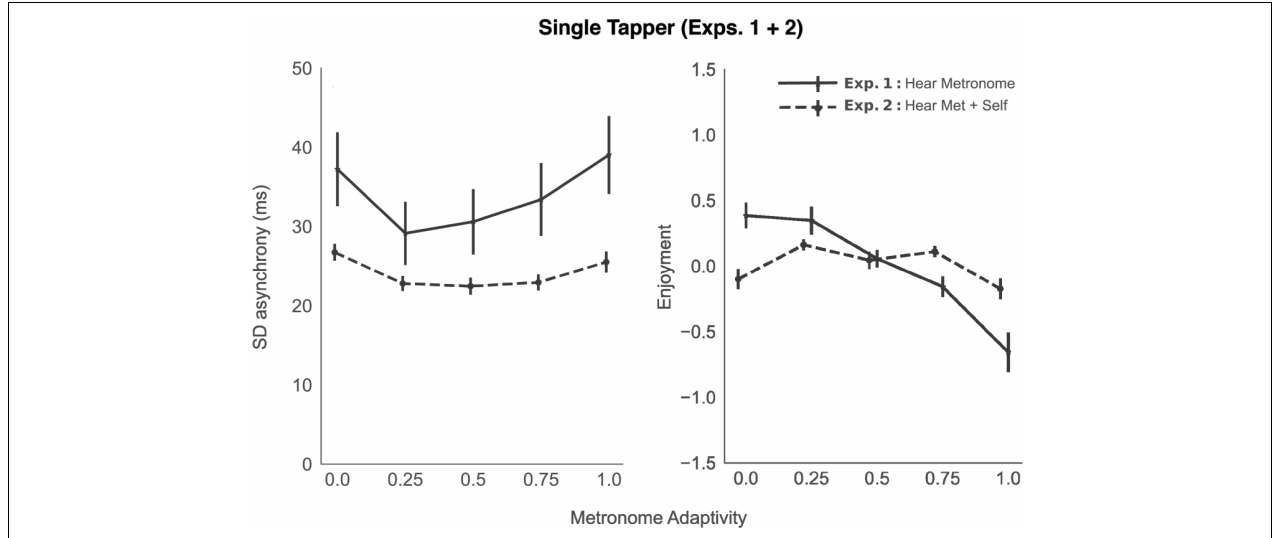
FIGURE 2 | Tapping performance (standard deviation of tap—metronome asynchrony), left panel, and subjective enjoyment, right panel, averaged across participants, as a function of metronome adaptivity, in the two single tapper experiments. Solid black lines represent experiments in which participants could only hear the sound produced by the metronome; dashed lines, experiments in which participants could hear the metronome and the sound of their own tap. Error bars represent standard error of the mean.